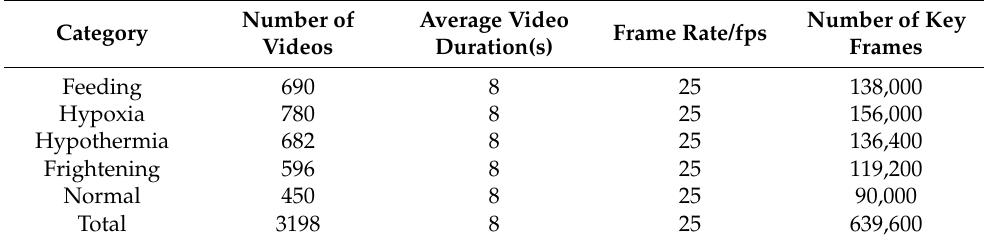
Table 2. Statistics of fish behaviors in our